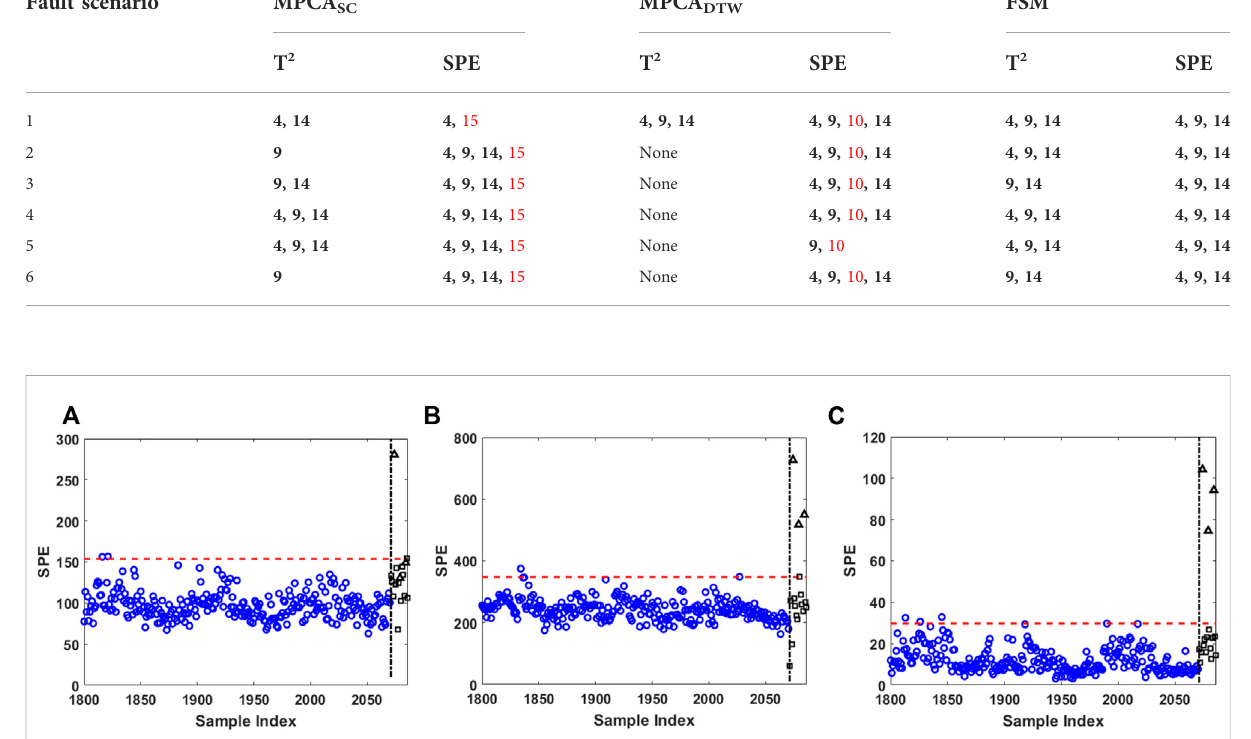
TABLE 4 Details of the fault detection results by T 2 and SPE. Correctly detected cycles are in bold black. Incorrectly detected cycles are in red. Fault scenario